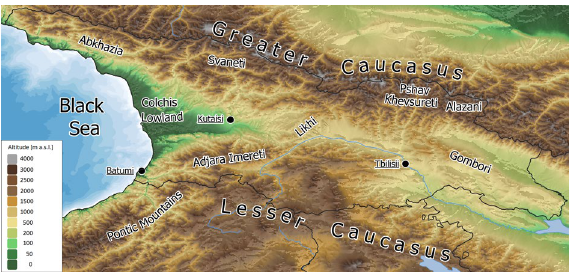
Figure 1. The major geographic regions of the Caucasus ecoregion. Map generated with QGIS 3.16 (https:// qgis. org/ en/